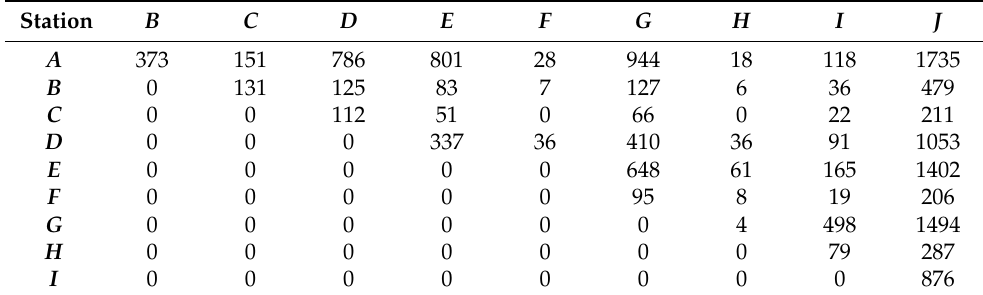
Table 8. Passenger OD